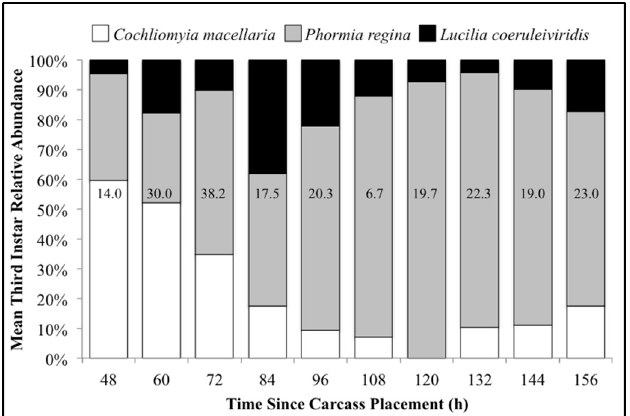
Figure 4. Mean relative abundance of all third instars collected throughout decomposition: Cochliomyia macellaria , Phormia regina , and Lucilia coeruleiviridis . Numbers on each column represent the average number of third instars (all species) collected at that time point.